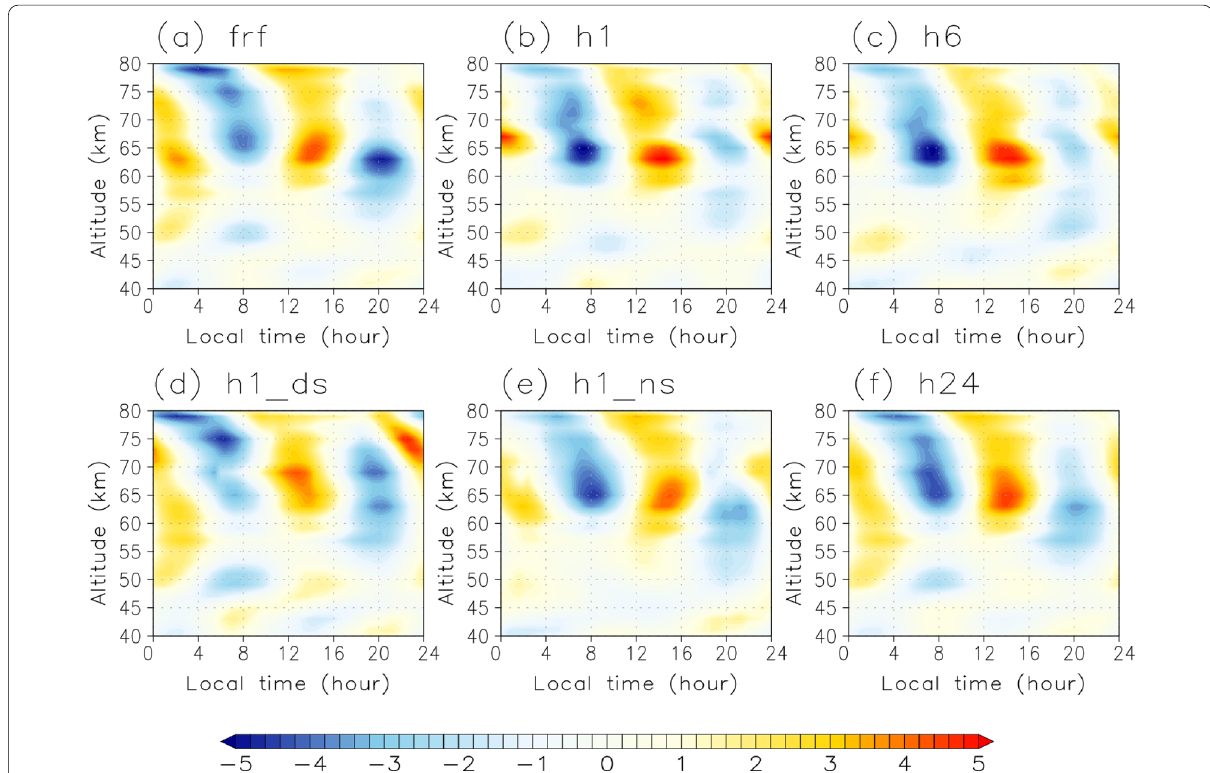
Fig. 3 Vertical distributions of temperature (K) deviations associated with the thermal tides at the equator. The cases of a frf, b h1, c h6, d h1_ds, e h1_ns, and f h24 are shown. These distributions are calculated by the composite means over 30 Earth days at the sub-solar point (fixed at the center of each panel). Amplitudes are multiplied by a factor of 100 √ σ for visibility, where σ is a scaled pressure level in the sigma coordinate